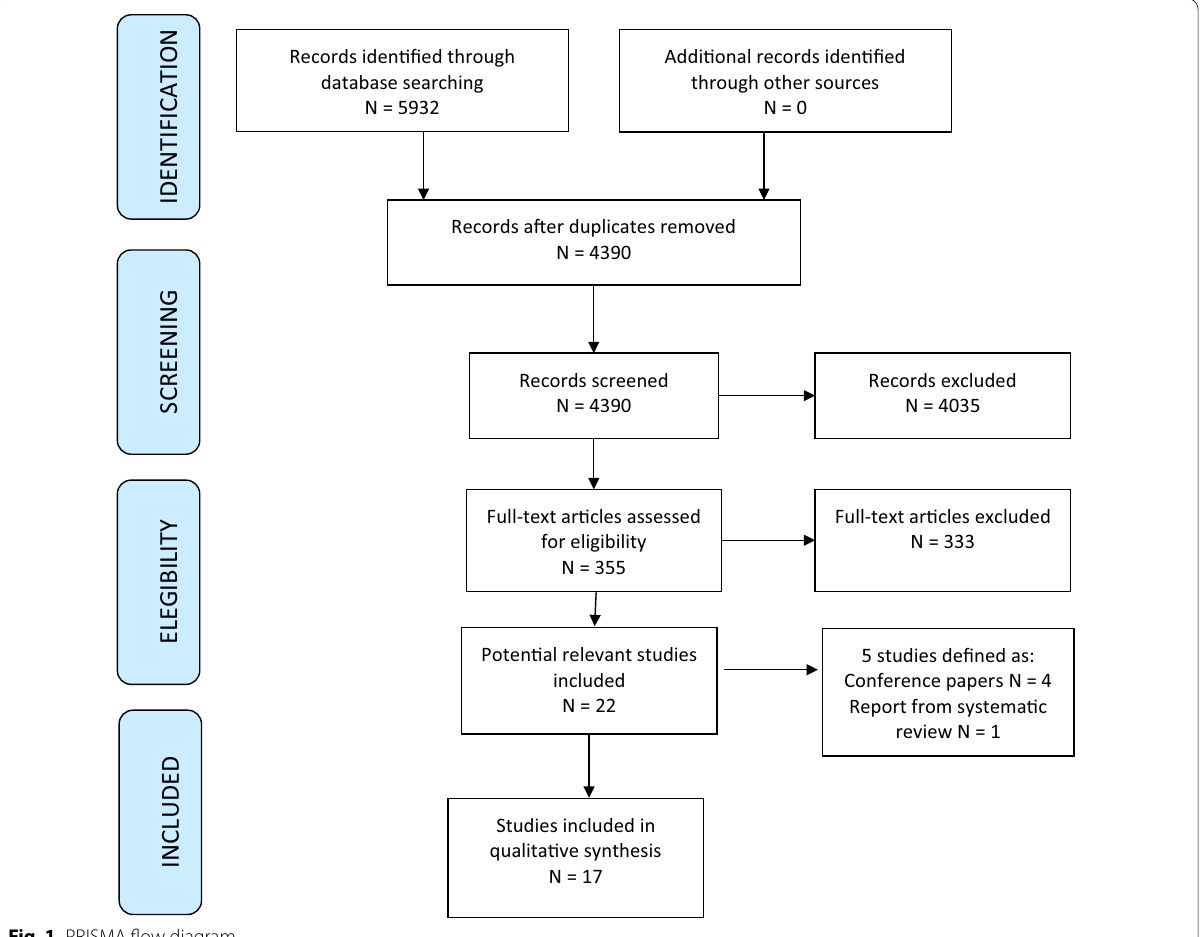
Fig. 1 PRISMA flow